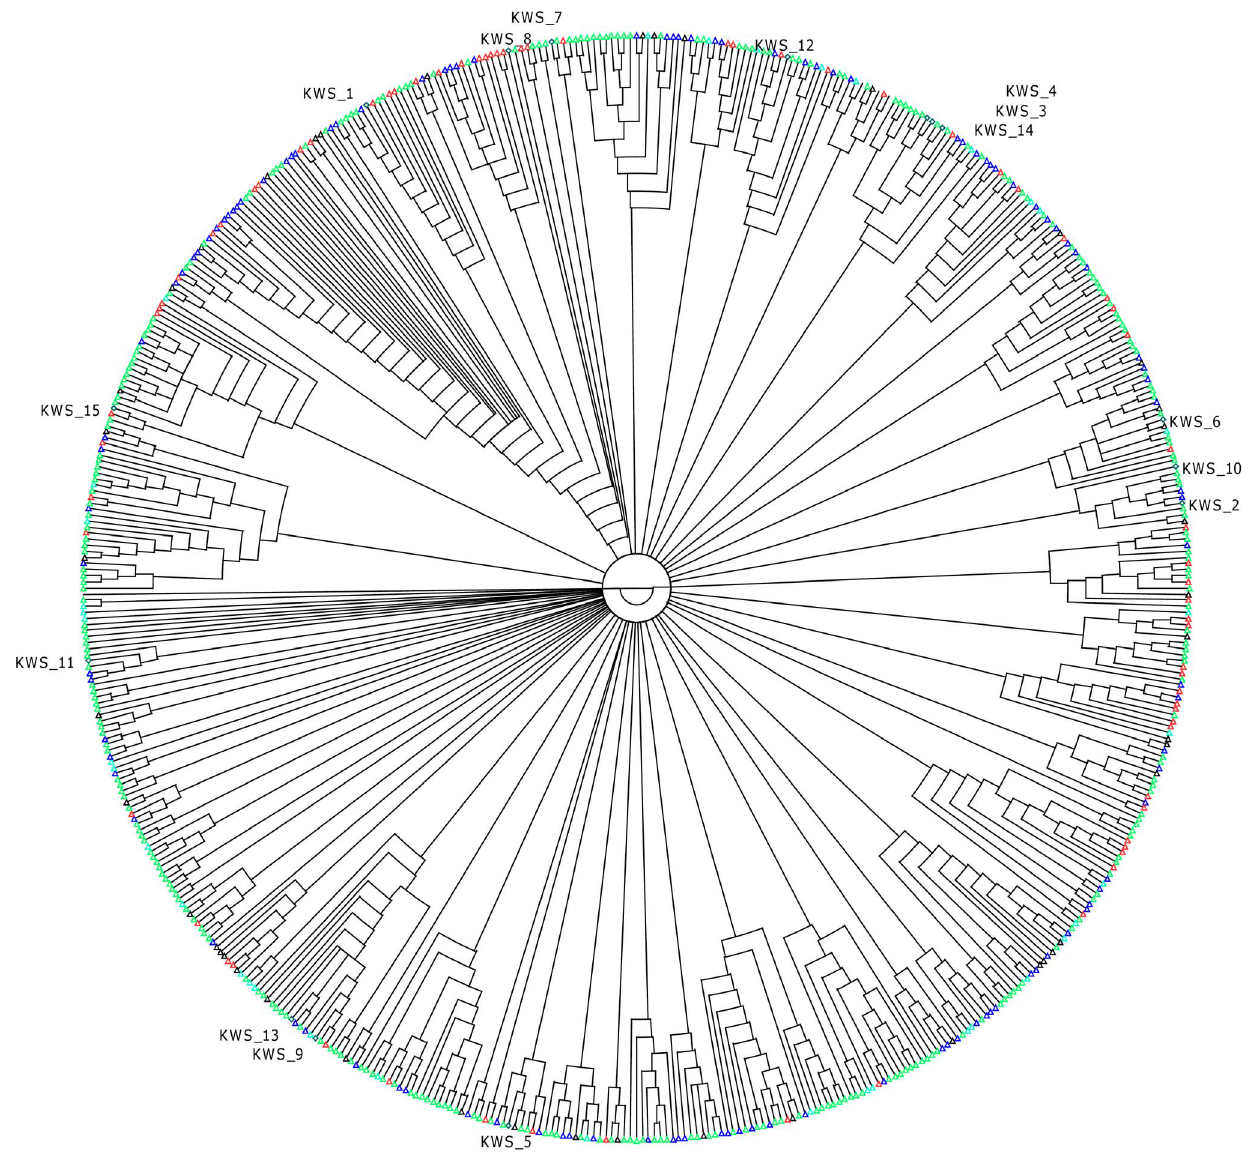
Figure 6. Phylogenetic tree of the observed HVS1 segments among the 15 participants together with those observed by Abu Amero [46] in Saudi Arabia natives. Kuwaiti samples are labeled as KWS. Green triangles denote sample from Central region of Saudi Arabia; Blue triangles denote samples from Southern region of Saudi Arabia; Red triangles denote samples from Western region of Saudi Arabia; Black triangles denote samples from Northern region of Saudi Arabia; Not Known [Cyan